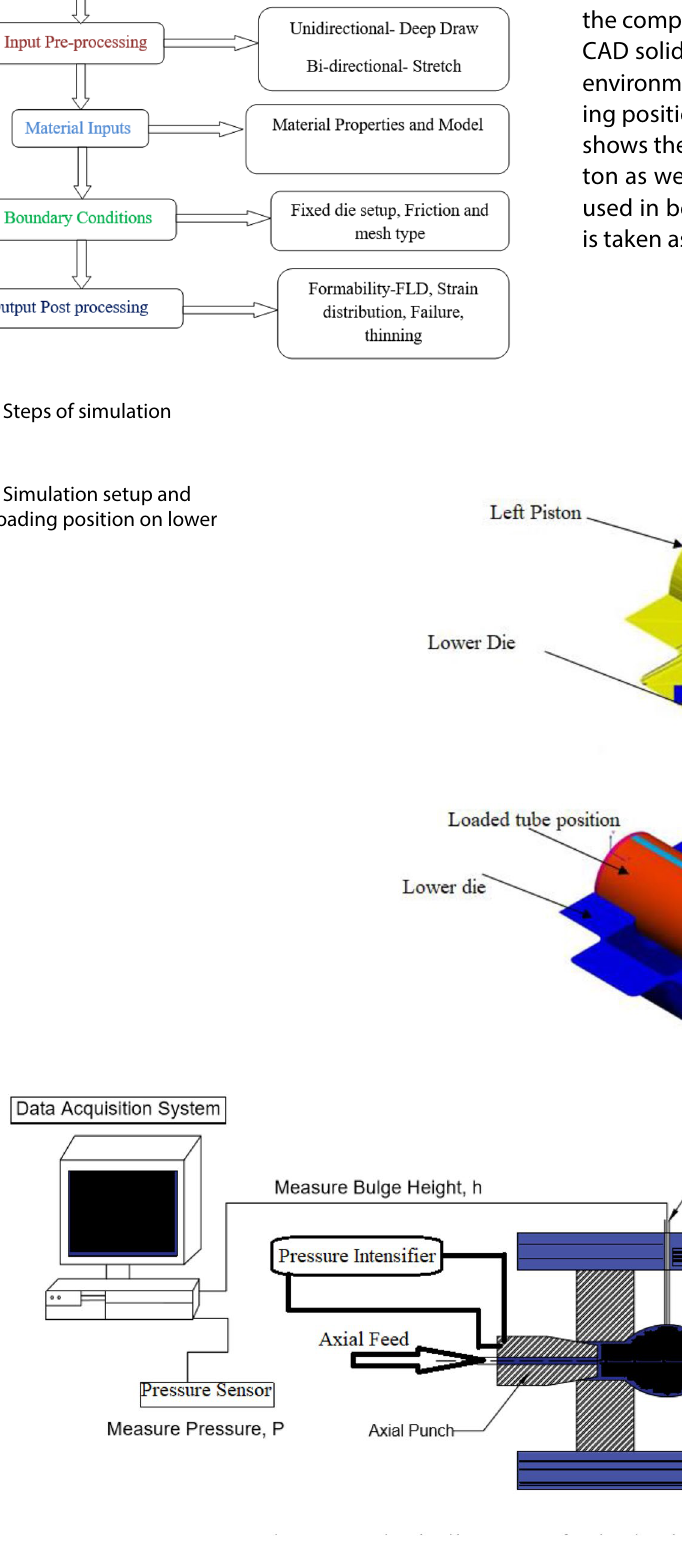
Fig. 3 Block diagram of tube hydroforming